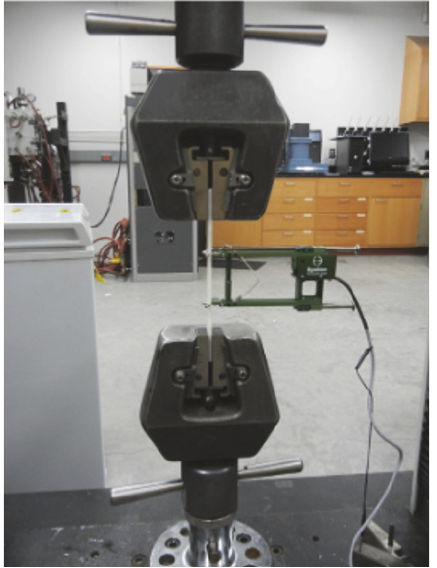
Figure 2: The photograph of a specimen in load frame.